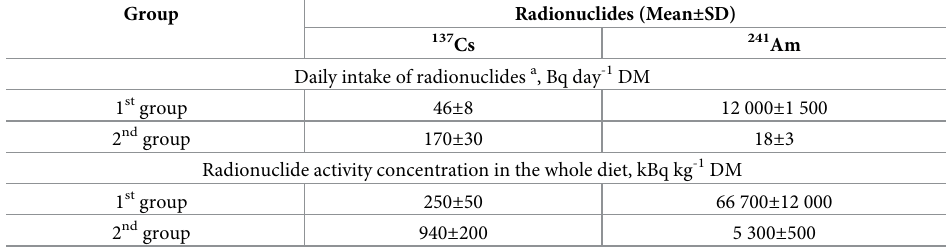
Table 3. Radionuclide activity concentration in the whole diet and daily intake of